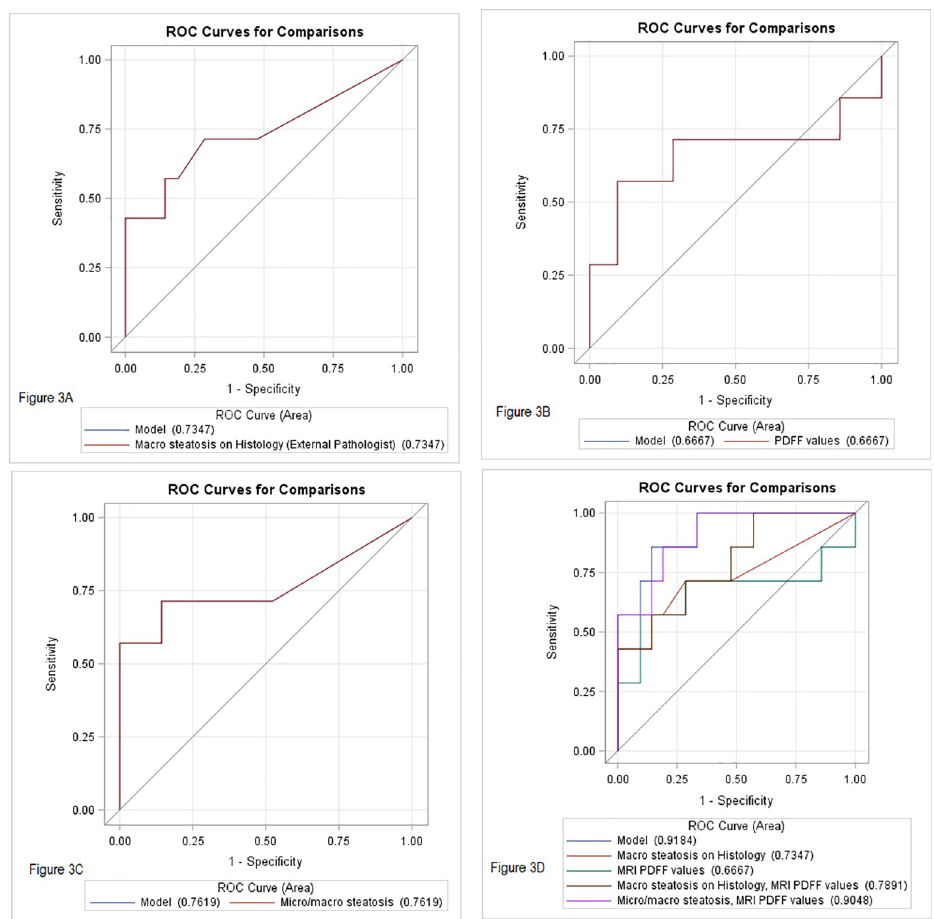
Fig 4. Comparison of area under ROC curves in predicting early allograft dysfunction based on degree of hepatic steatosis (external pathologist- read out). Results are compared for hepatic steatosis quantification based on histology and MRI PDFF